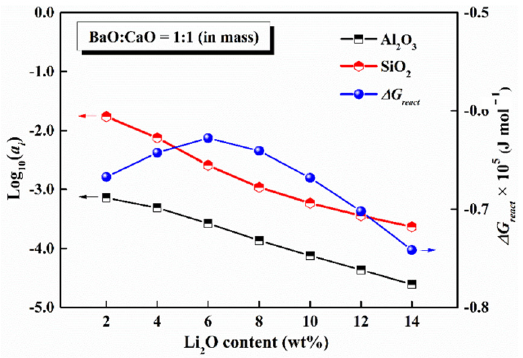
Figure 8. Effect of Li 2 O content on the activities of Al 2 O 3 and SiO 2 and the reactivity of mold flux.